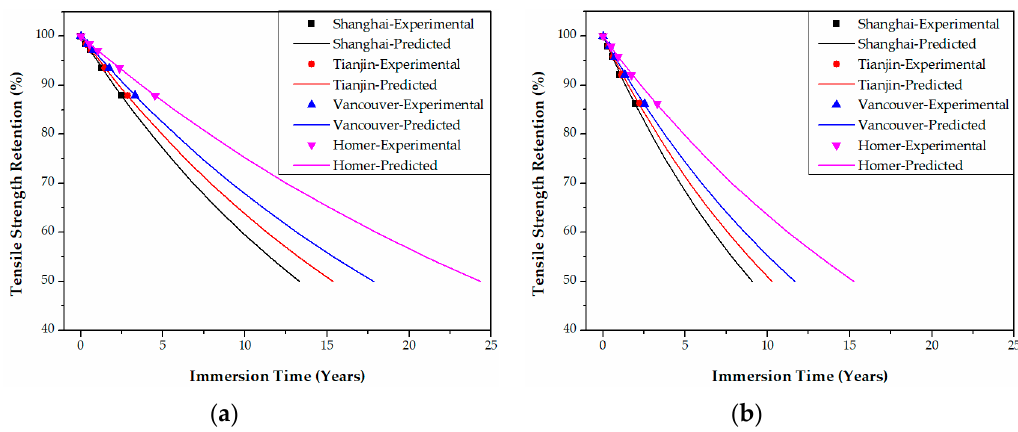
Figure 23. Life prediction of the tensile strength for PU-based CFRPs (58% strain) immersed in distilled water ( a ) and seawater ( b ) in the four cities, respectively.